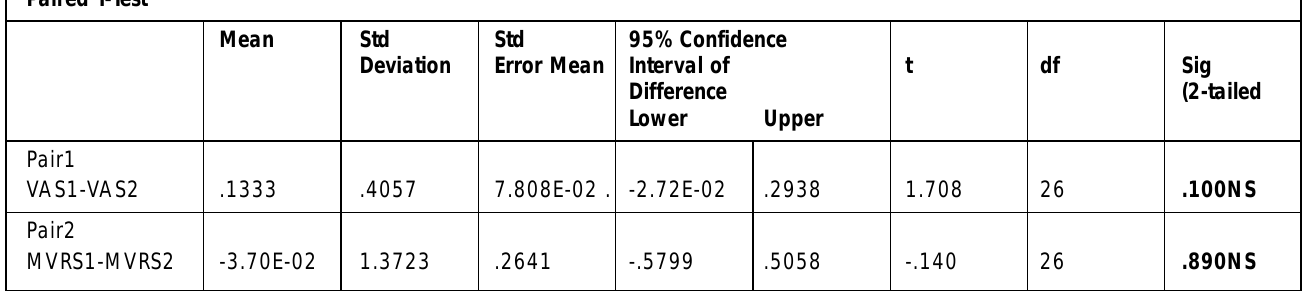
Table 5: Interater Reliability of VAS and MVRS Pain